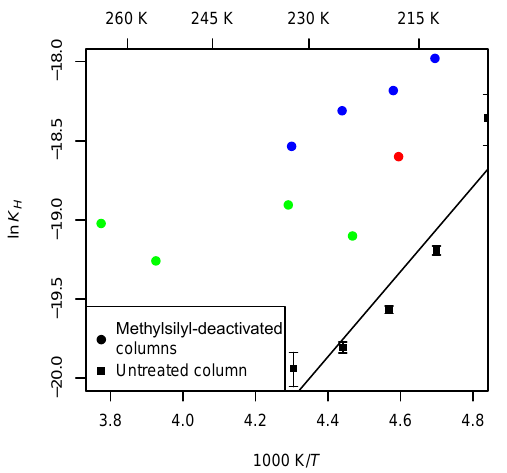
Figure 5. Chromatograms of a mixture of methane, n -hexane and acetone at different temperatures. The flow rate is 10sccm. Methane is used as a non-adsorbable tracer.